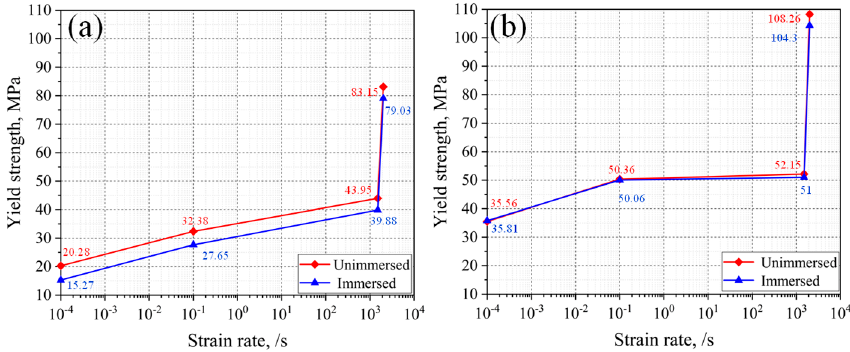
Figure 10. Comparison of yield strength versus strain rate of ( a ) PA12 and ( b ) CF/PA12.